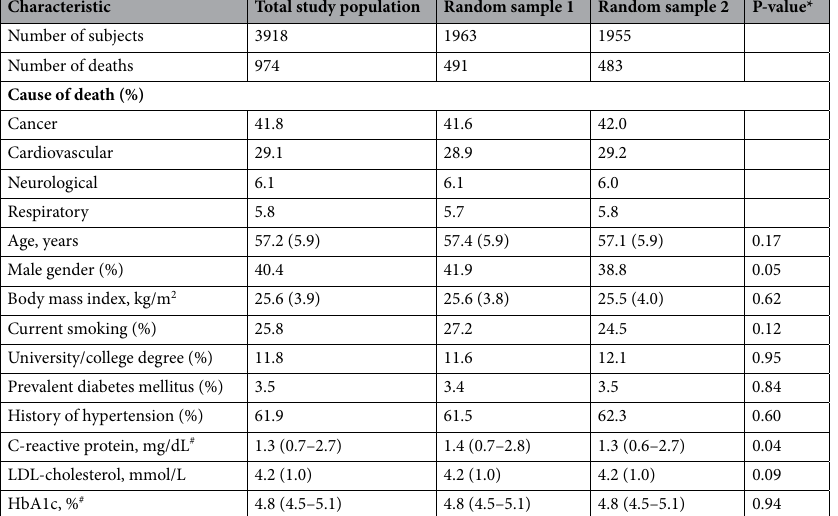
Table 1. Description of the MDCS-CVA and two random samples of the study population. *Mean (standard deviation, SD) are shown unless otherwise noted. Chi-square test (categorical variables) and ANOVA (continuous variables) used to test differences in characteristics between random sample 1 and 2. # Median (interquartile range) and P-value from ANOVA using ln-transformed variable due to non-normal